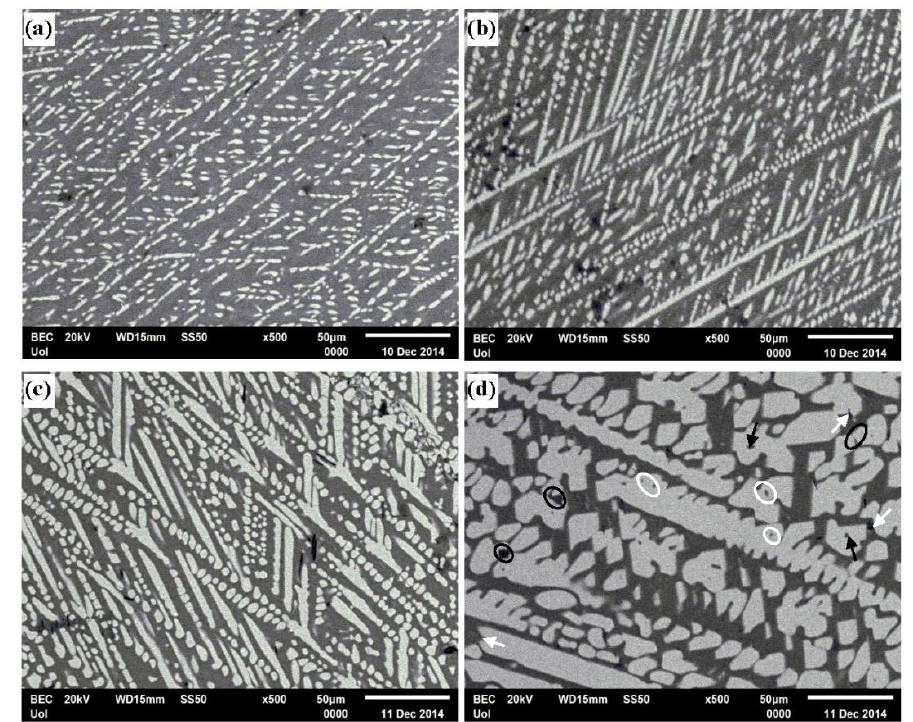
Figure 2. Microstructure of the alloys, as fabricated (BSE mode): ( a ) Al-7wt.% Co; ( b ) Al-10 wt.% Co; ( c ) Al-15 wt.% Co; ( d ) Al-20 wt.% Co; white outlined ellipses: pores at the intersections of dendrites and dendrite arms; black outlined ellipses: narrow and closed gaps in the matrix between Al 9 Co 2 particles; white arrows: pores, microdefects at sharp points of Al 9 Co 2 particles; black arrows: pores in the middle of Al 9 Co 2 phase.